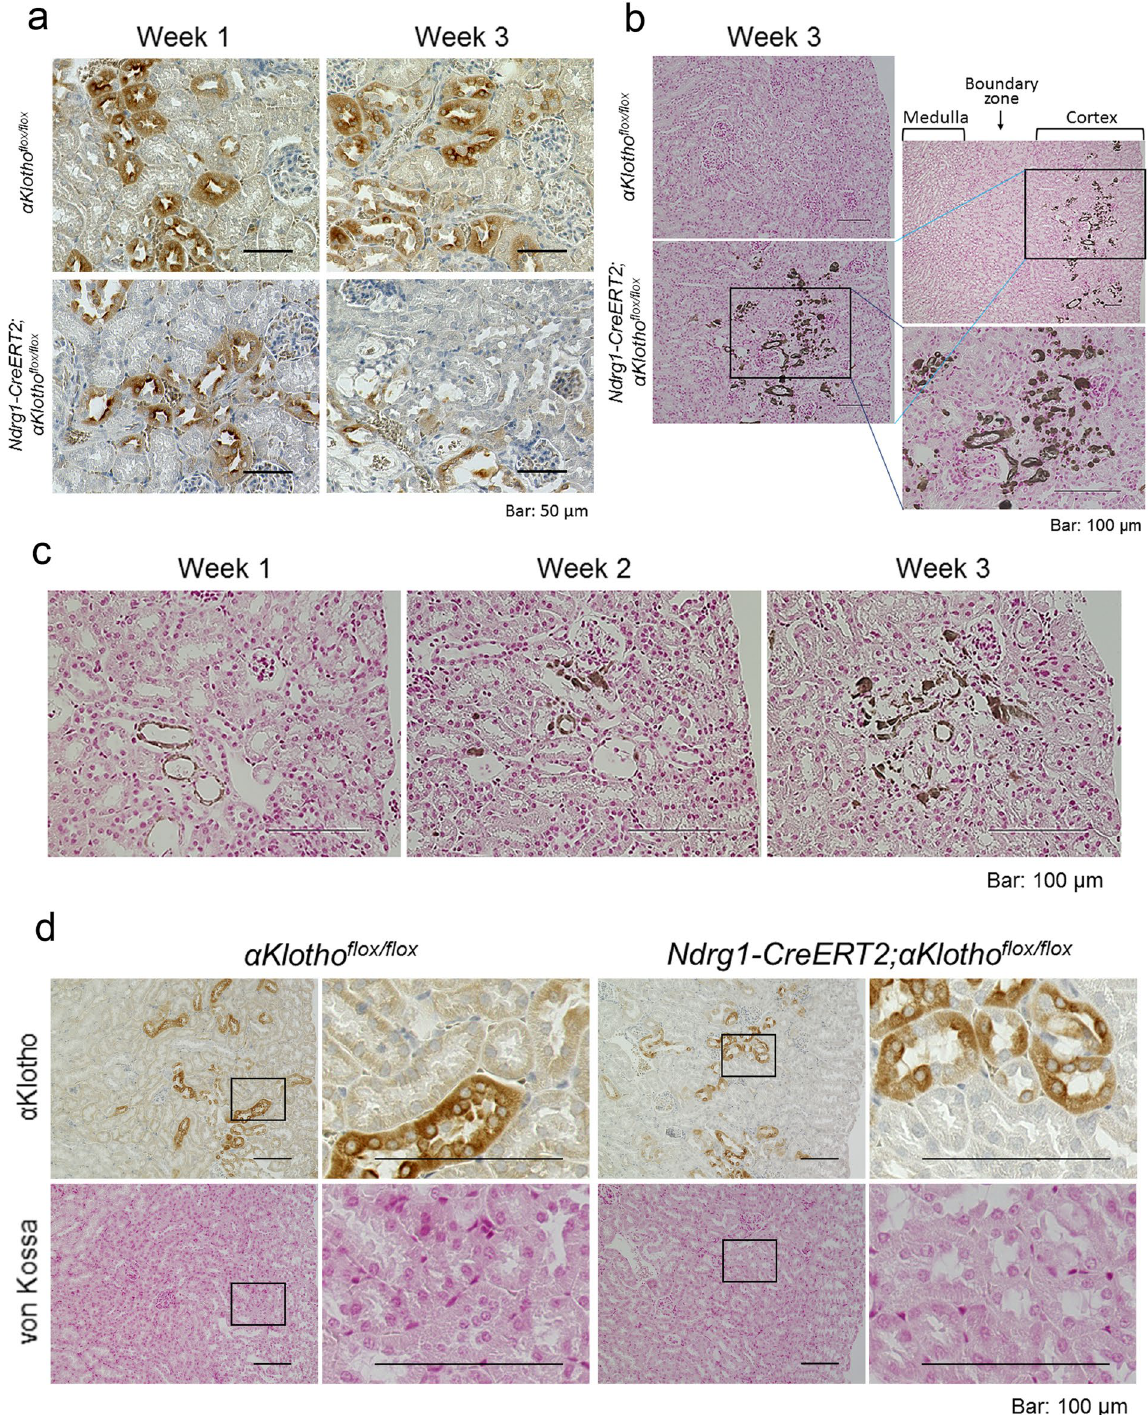
Figure 2. Proximal tubule-specific α Klotho cKO induces ectopic calcification in the kidney cortex and reduces α Klotho expression in distal tubules, both of which can be reversed by a vitamin D-deficient diet. ( a ) α Klotho expression in the kidney of α Klotho flox / flox and Ndrg1-CreERT2; α Klotho flox / flox mice 1 and 3 weeks after tamoxifen treatment. Kidney sections were stained for α Klotho using DAB with counterstaining by hematoxylin. At 1 week after tamoxifen treatment, α Klotho staining was significantly reduced in proximal tubules, whereas distal convoluted tubules retained α Klotho expression. At 3 weeks after tamoxifen treatment, non-stained (by either DAB or hematoxylin) empty areas became evident in the cortex, and α Klotho expression was reduced dramatically in distal convoluted tubules in addition to its deleted expression in proximal tubules. Kidney cortical surface is oriented to the right. Scale bars: 50 μ m. ( b ) Renal ectopic calcification. Kidney sections from mice treated with tamoxifen for 3 weeks were stained for calcified tissue (dark brown) using the von Kossa method. Ndrg1-CreERT2; α Klotho flox / flox mice showed marked calcification in only the cortex, whereas α Klotho flox / flox